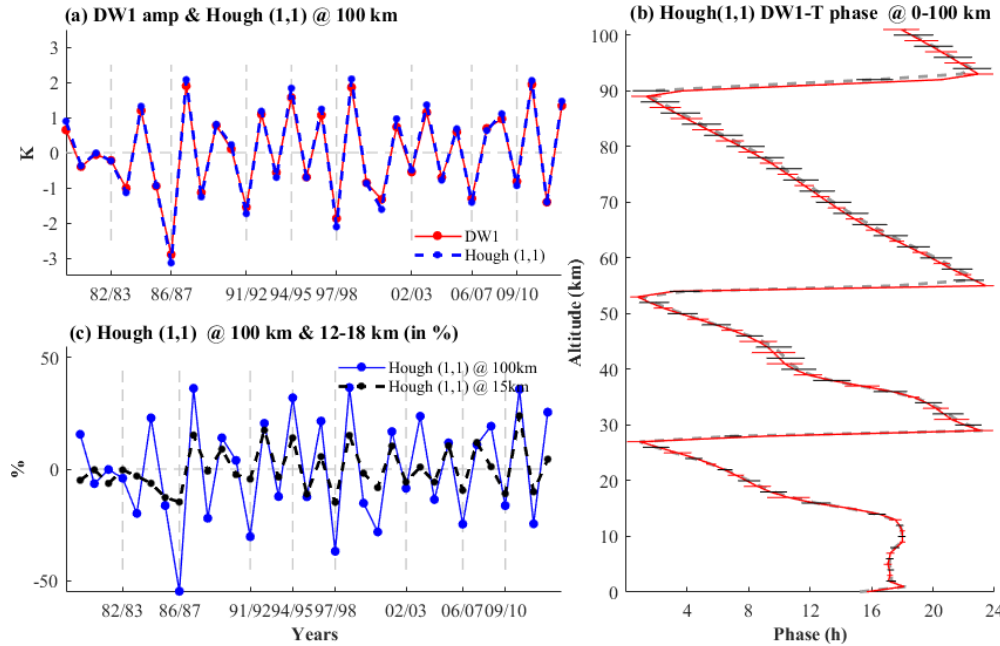
Figure 4. (a) The solid red line indicates the anomalous DW1 temperature amplitude of SD-WACCM simulations averaged over 10 ◦ S– 10 ◦ N at 100km during the 1979–2013 winter (DJF). The blue dotted line indicates the Hough (1,1) mode of the DW1 temperature amplitude residual at 100km during the 1979–2013 winter (DJF). (b) The thin black dotted line indicates the Hough (1,1) DW1-T phase of SD-WACCM simulations at 0–100km during the 1979–2013 winter (DJF). The thick black horizontal line indicates the standard deviation of the DW1-T phase. The solid red line is the same but for El Niño winter. (c) The solid blue line is the same as in (a) , and the black dotted line is the same but for 15km. Table 2. The correlation coefficient between the DW1-T amplitude at 15km and the mass-weighted HR in different areas during the winters of 1979–2014. The bold numbers indicate that the correlation coefficients are significant at 95%. The MLR coefficient on the normalized Niño3.4 index (10 − 3 mwm − 3 per index) is also exhibited. Altitude and latitude